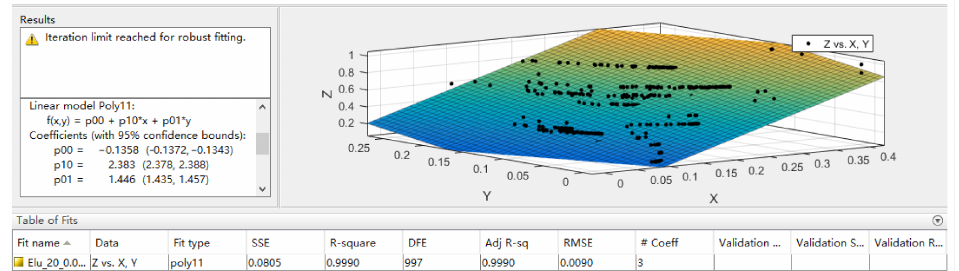
Figure 8. Least squares algorithm fitting effect